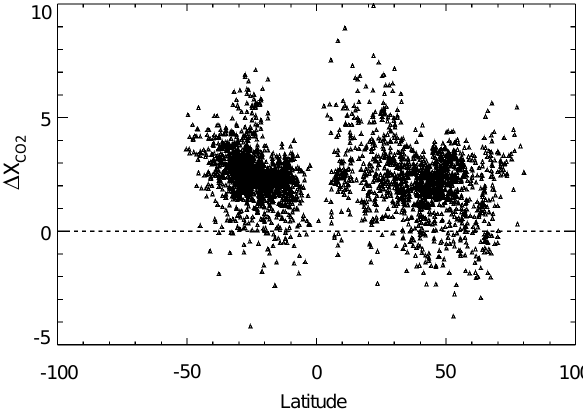
Fig. 14. Histogram of differences between the retrieved pres- sure and the ECMWF prior, 1P surf for sounding retrieved using Figure 14. Histogram of differences between the retrieved pressure and the ECMWF prior, 3 scaled ABO2 absorption coefficients. The data set used here in- cludes all soundings over land collected in 23–25 April 2009, 1– for sounding retrieved using scaled ABO2 absorption coefficients. The data set used 4  P surf 31 July 2009; 18–20 September, and 14–16 January 2010 that pass the 85 ◦ solar zenith angle and cloud screening tests. Rescaling the here includes all soundings over land collected in 23-25 April 2009, 1-31 July 2009; 18-20 5 O 2 absorption coefficients largely eliminates the global bias and September, and 14-16 January 2010 that pass the 85° solar zenith angle and cloud screening 6 yields a standard deviation comparable to that assumed in the a pri- tests. Rescaling the O 2 absorption coefficients largely eliminates the global bias and yields a 7 ori covariance matrix ( ± 4hPa). standard deviation comparable to that assumed in the a priori covariance matrix (± 4 hPa). 8